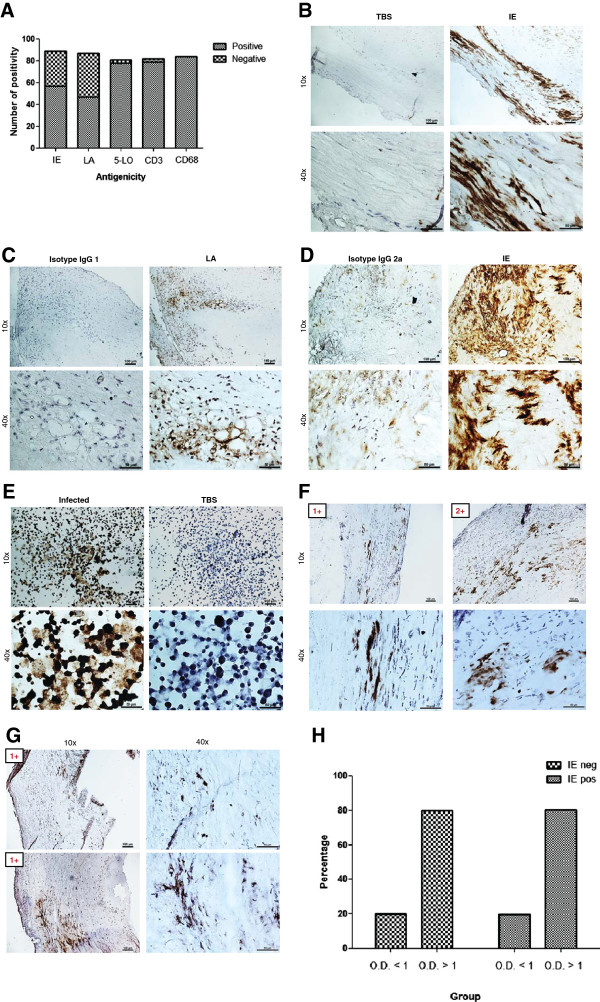
Immunoreactivity and grading of human cytomegalovirus (HCMV) antigens and inflammatory markers in human carotid atherosclerotic plaques as assayed by immunohistochemistry (IHC) staining. (A) Summary of IHC results on viral immediate early (IE), late (LA), 5-LO, CD3 and CD68 in plaques. (B-E) Panel of controls consist of omitting primary antibody (or Tris-buffered saline, TBS only) instead of IE (B), isotype control for LA (C), isotype control for IE (D), and virus-infected endothelial cells (E). (F-G) Immunoreactivity and grading of IE (F) or LA (G) in plaques. (H) Association between HCMV IgG antibodies and its IE antigens burden. Positivity was revealed by diaminobenzidine (DAB), brown products; Optical density, O.D.